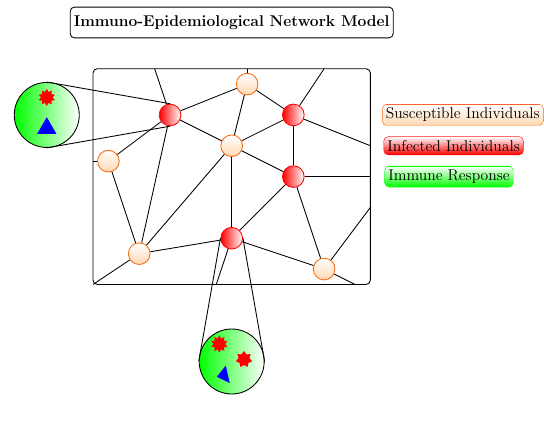
Fig. 3. Network immuno-epidemiological schematic dia-